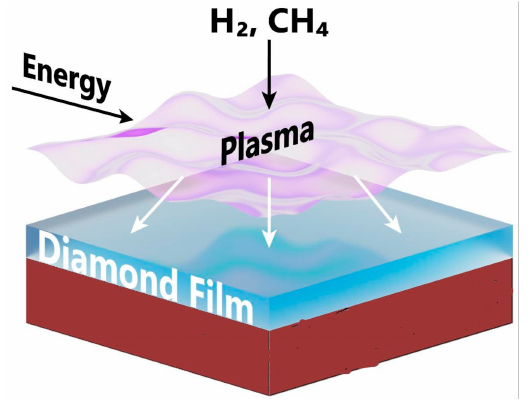
Figure 3. Diagram summarizing the M-CVD process: microwave-enhanced methane-hydrogen plasma covers a diamond film, which acts as the initial seed.